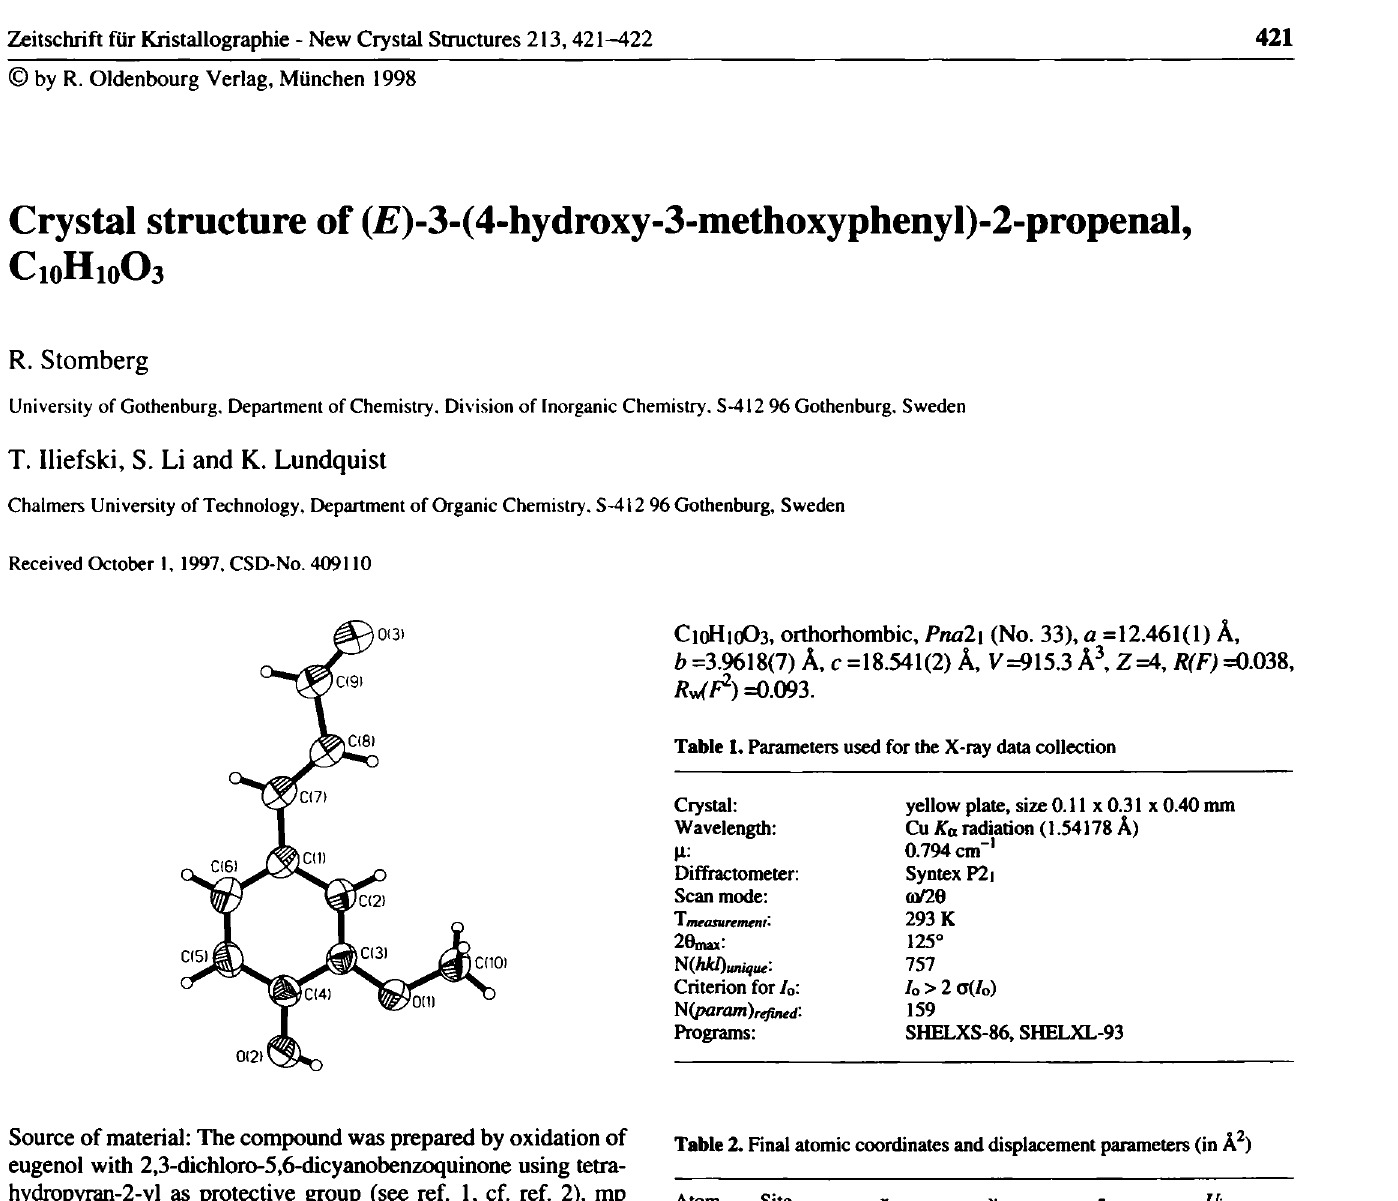
Table 2. Final atomic coordinates and displacement parameters (in Â^) Atom